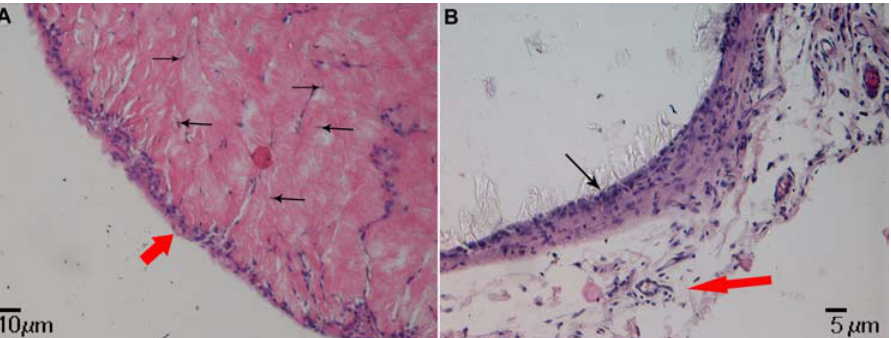
Figure 5. Haematoxilin and Eosin staining. ( A ) In vivo sample on concave PLGA scaffold (Calibration Bar=10 m m). The figures shows that the bone tissue is of great thickness with an evident periosteal layer (red arrow) and containing osteocytes entrapped within the matrix (black arrows). ( B ) In vivo sample on smooth PLGA scaffold (Calibration Bar=5 m m) appeared to be more primitive, thin (black arrow) and not as well developed above a connective loose tissue containing vessels (red arrow).